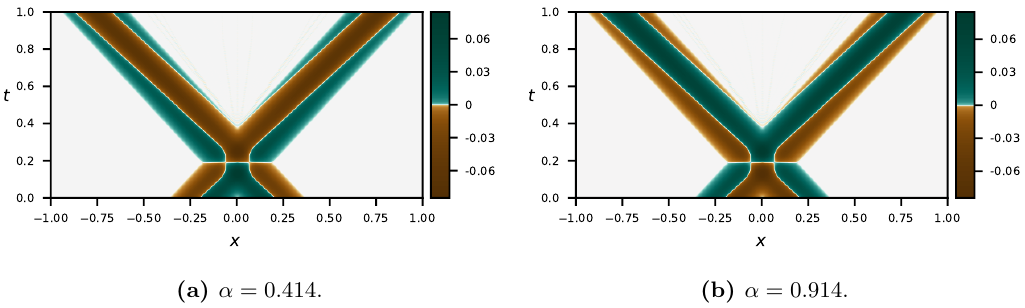
Figure 22 . The scatterings of the symmetric initial con(cid:12)guration with V = 0 : 93, v = 0. The scattered oscillons have phase (a) (cid:11) = 0 : 414 and (b) (cid:11) = 0 : 914.